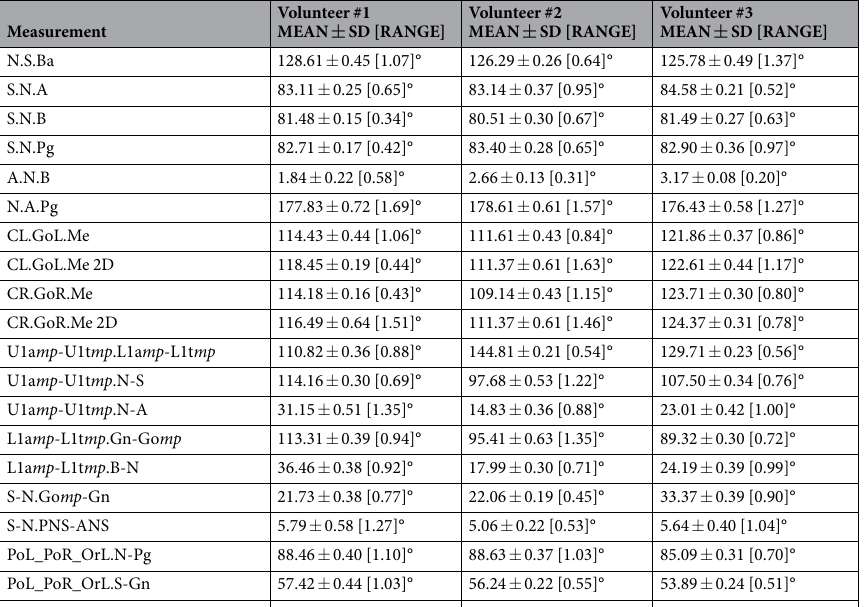
Table 3. Reproducibility of angular in vivo measurements. All angles were calculated from cephalometric landmarks determined on multiplanar reconstructions as shown in Fig. 3. 2D measurements were projected on the midsagittal plane (N_ANS_PNS). All mean, SD and range values refer to 5 MRI scans in different head positions for each study participant. All p-values were generated by repeated measures one-way analysis of variance. p-values > 0.05 indicate no significant differences between the 5 measurement rounds. Definitions of angles: N.S.Ba = Angle between lines N-S and S-Ba (‘cranial base angle’); S.N.A = Angle between lines S-N and N-A; S.N.B = Angle between lines S-N and N-B; S.N.Pg = Angle between lines S-N and N-Pg; A.N.B = angle between lines A-N and N-B; N.A.Pg = Angle between lines N-A and A-Pg; CL.GoL.Me = Angle between lines CL-GoL and GoL-Me (‘left gonial angle’); CR.GoR.Me = Angle between lines CR-GoR and GoR-Me (‘right